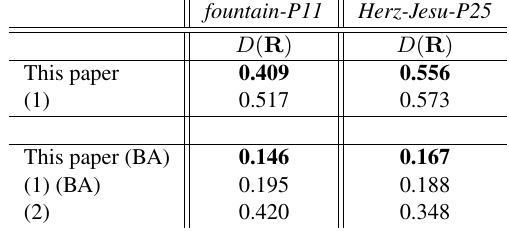
Table 2: Orientation results of the two datasets with respect to the ground truth in comparison with results from recent publications: (1): (Jiang et al., 2013), (2): (Arie-Nachimson et al., 2012). The upper part shows results before, the lower part after performing bundle adjustment. D ( R ) is the mean distance to ground truth in [ ◦ ]